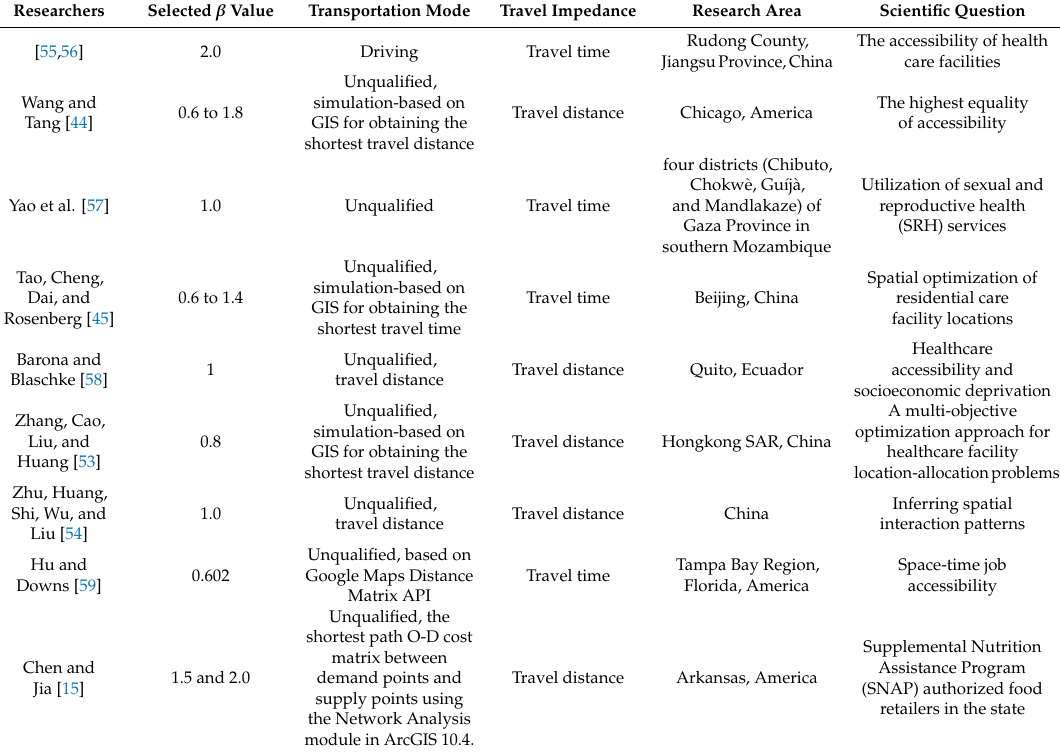
Table 1. Di ff erent travel friction coe ffi cients β in the research of